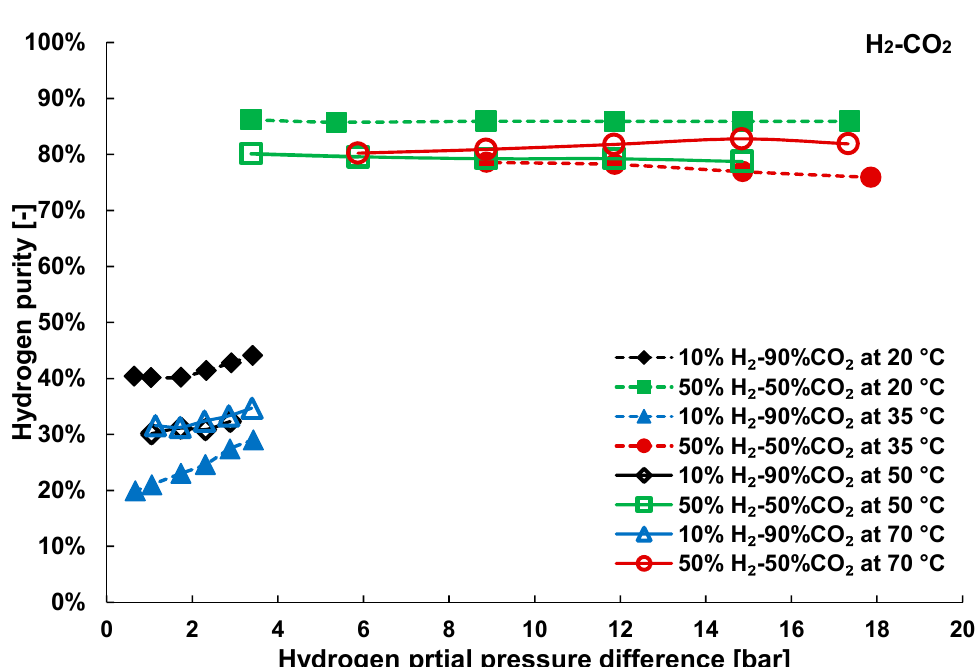
Figure 13. Comparison between hydrogen purity in an H 2 -CO 2 mixture with 10% and 50% hydrogen concentration at 20, 35, 50 and 70 °C, for CMSM-550.